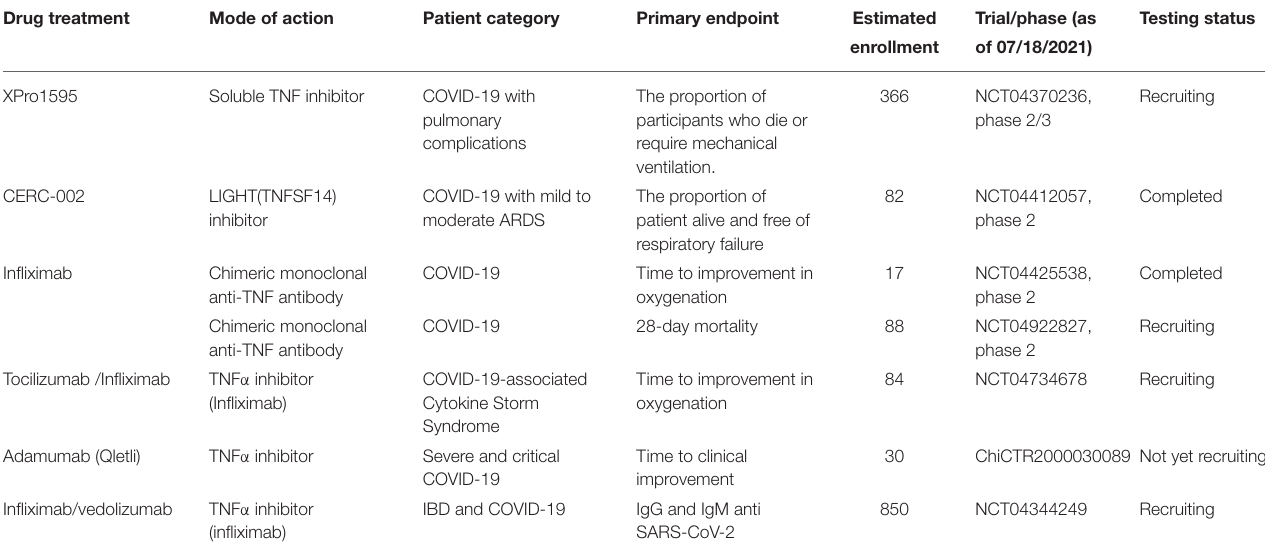
TABLE 1 | Drugs targeting TNF or its receptor in clinical studies in patients with COVID-19. Drug